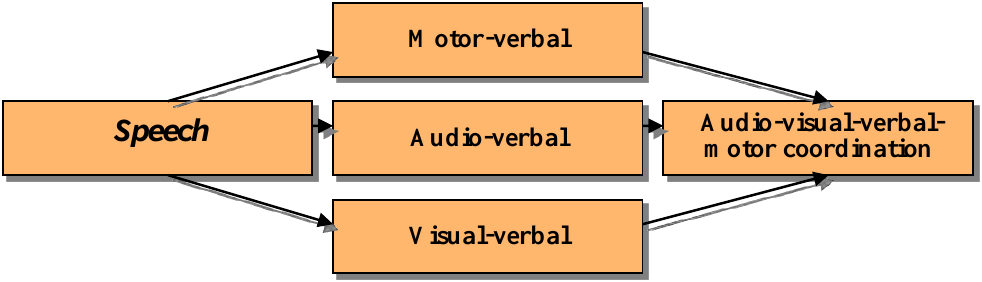
Fig. 2. Rhythmic structural components of professional activity of the physical culture specialist (coordination aspect) The process of rhythmic structures’ formation in professional activity can be presented within the framework in the Conceptual Model (fig.